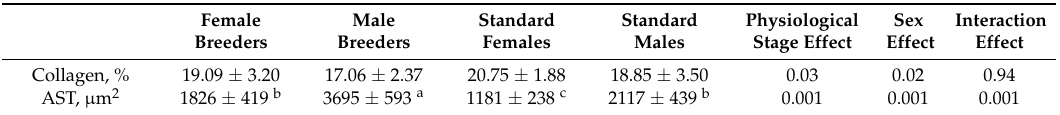
Table 7. Relative area occupied by collagen and cross-sectional area (CSA) of muscle fibers of Pectoralis major muscle from males and females of breeder and standard turkeys ( n = 13).